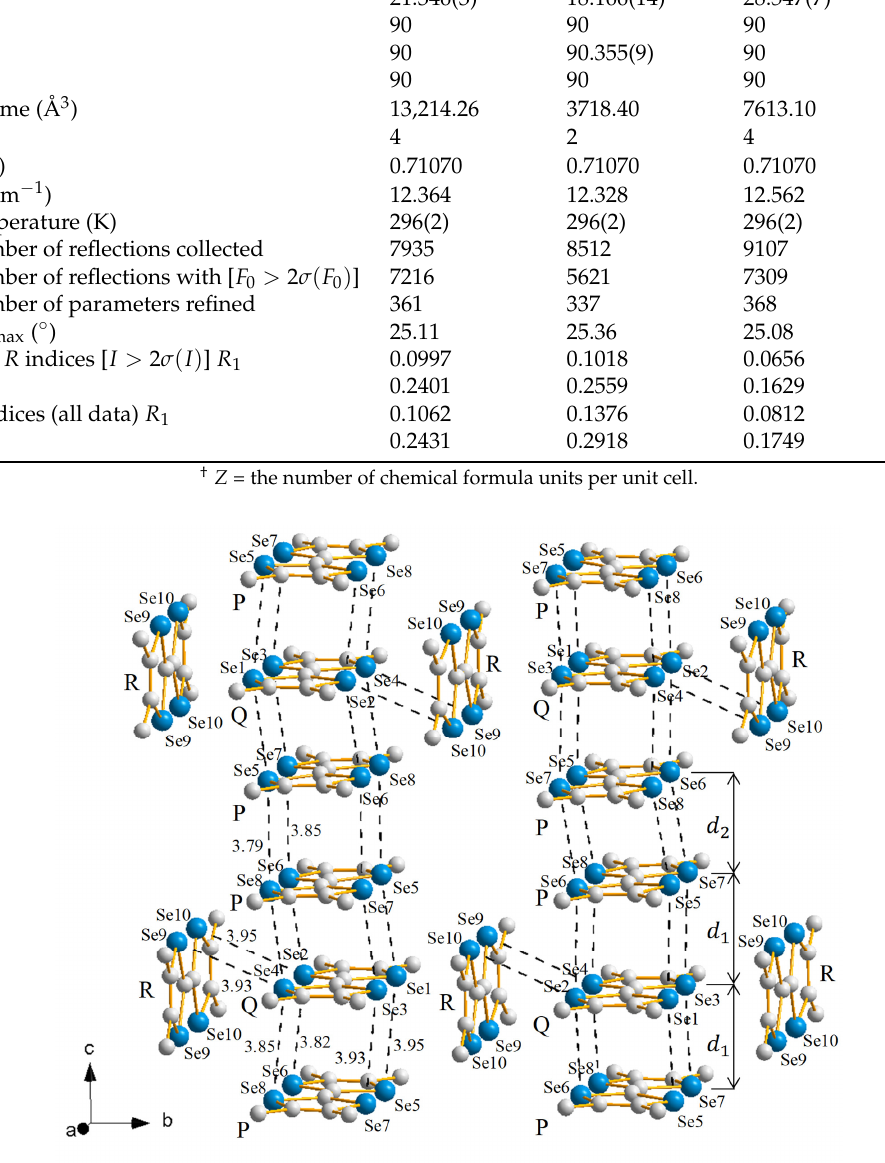
Figure 2. Donor arrangement in a half unit cell of (TMTSF) 8 (I 3 ) 5 . Hydrogen atoms are not shown for clarity. The crystallographically independent TMTSF molecules are labeled P, Q, and R, respectively. The broken lines show the Se · · · Se contacts shorter than 4.0 Å, namely the sum of van der Waals radii of two Se atoms (see text). The interplanar distance between P and Q is d 1 = 3.56 ( 1 ) Å; and that between P and P is d 2 = 3.559 ( 8 ) Å,